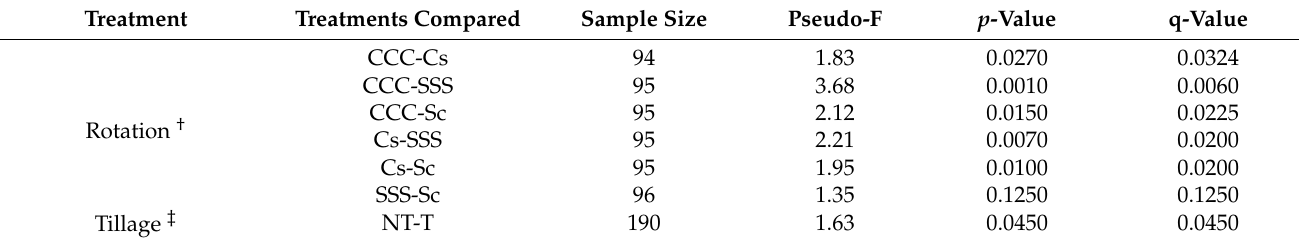
Table 3. Community structure ( β -diversity) measures for fungi following 20 years of crop rotation and tillage treatments, and their interaction, based on pairwise permanova computation of weighted unifrac distances. The pseudo-F column represents the comparison between UniFrac distances for a given treatment combination (listed in the Treatments Compared column). The p -value and q-value columns indicate the probability of type I and type II errors associated with the treatment comparisons,